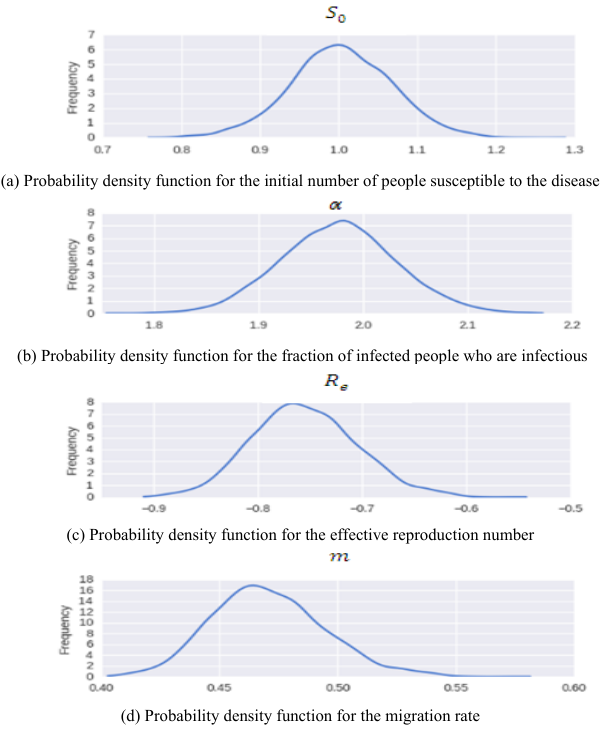
Figure 3. Posterior Density Functions Estimated From Model Parameters